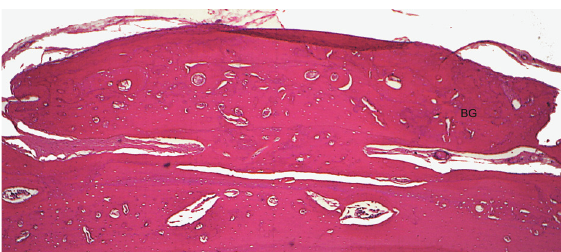
Figure 3- Group I – 30 days: Bone graft (BG) incorporated to the recipient site. New bone formation at the interface observed only at the graft central region, where the (hematoxylin-eosin – Original 100x)